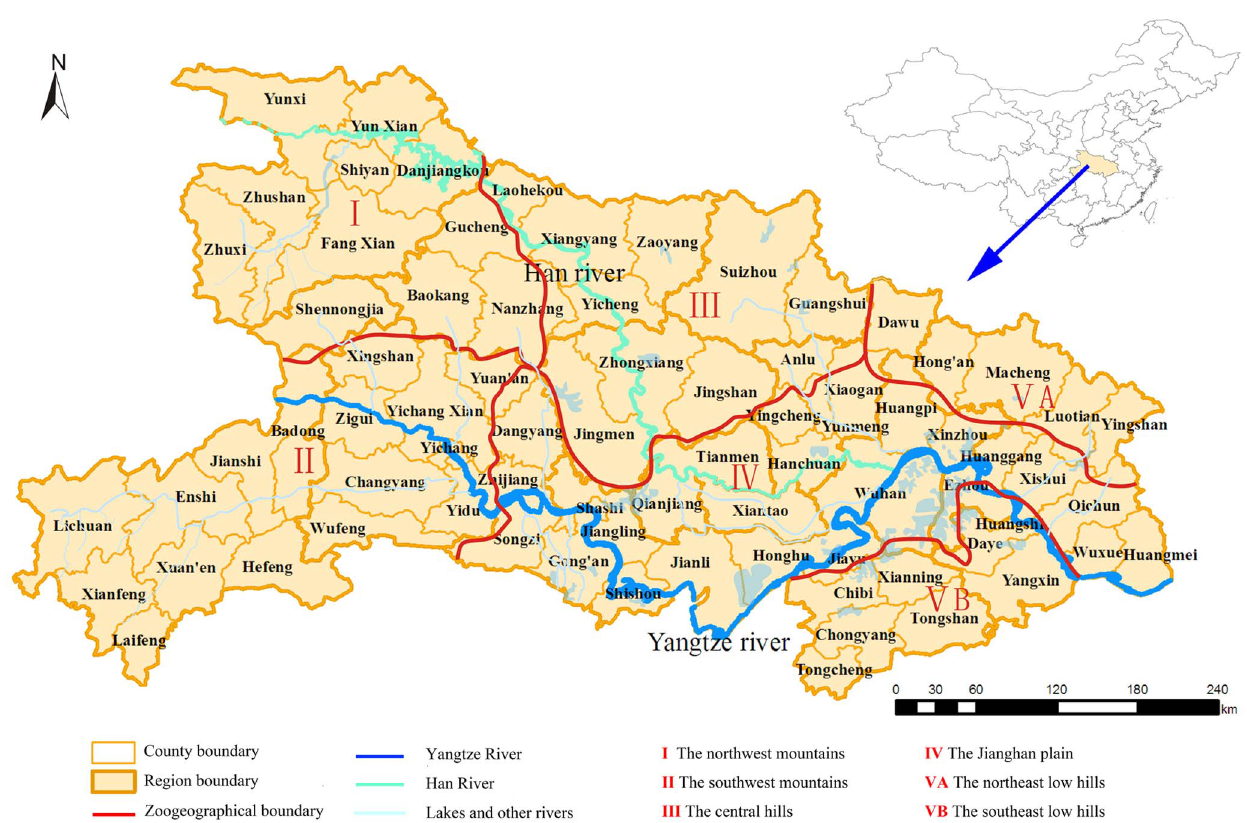
Figure 1. The location and division of study area, Hubei Province in Mainland China.